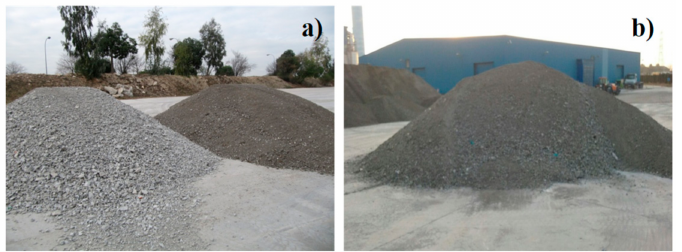
Figure 2. ( a ) Image of the particle size of crushed M and ( b ) spillage of WBA in the plant feeding silos.